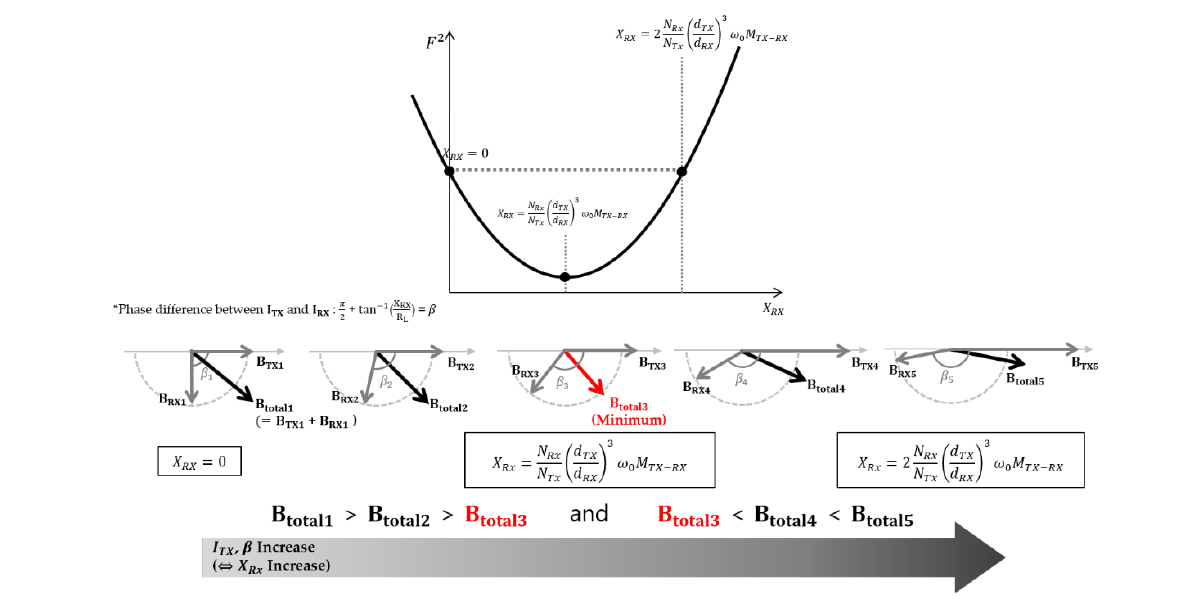
Figure 7. The conceptual diagram of the proposed method.